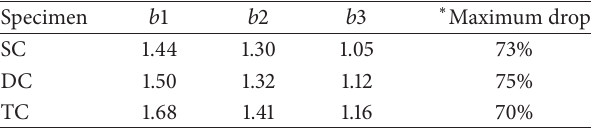
Table 4: The average 𝑏 -values for each stage of